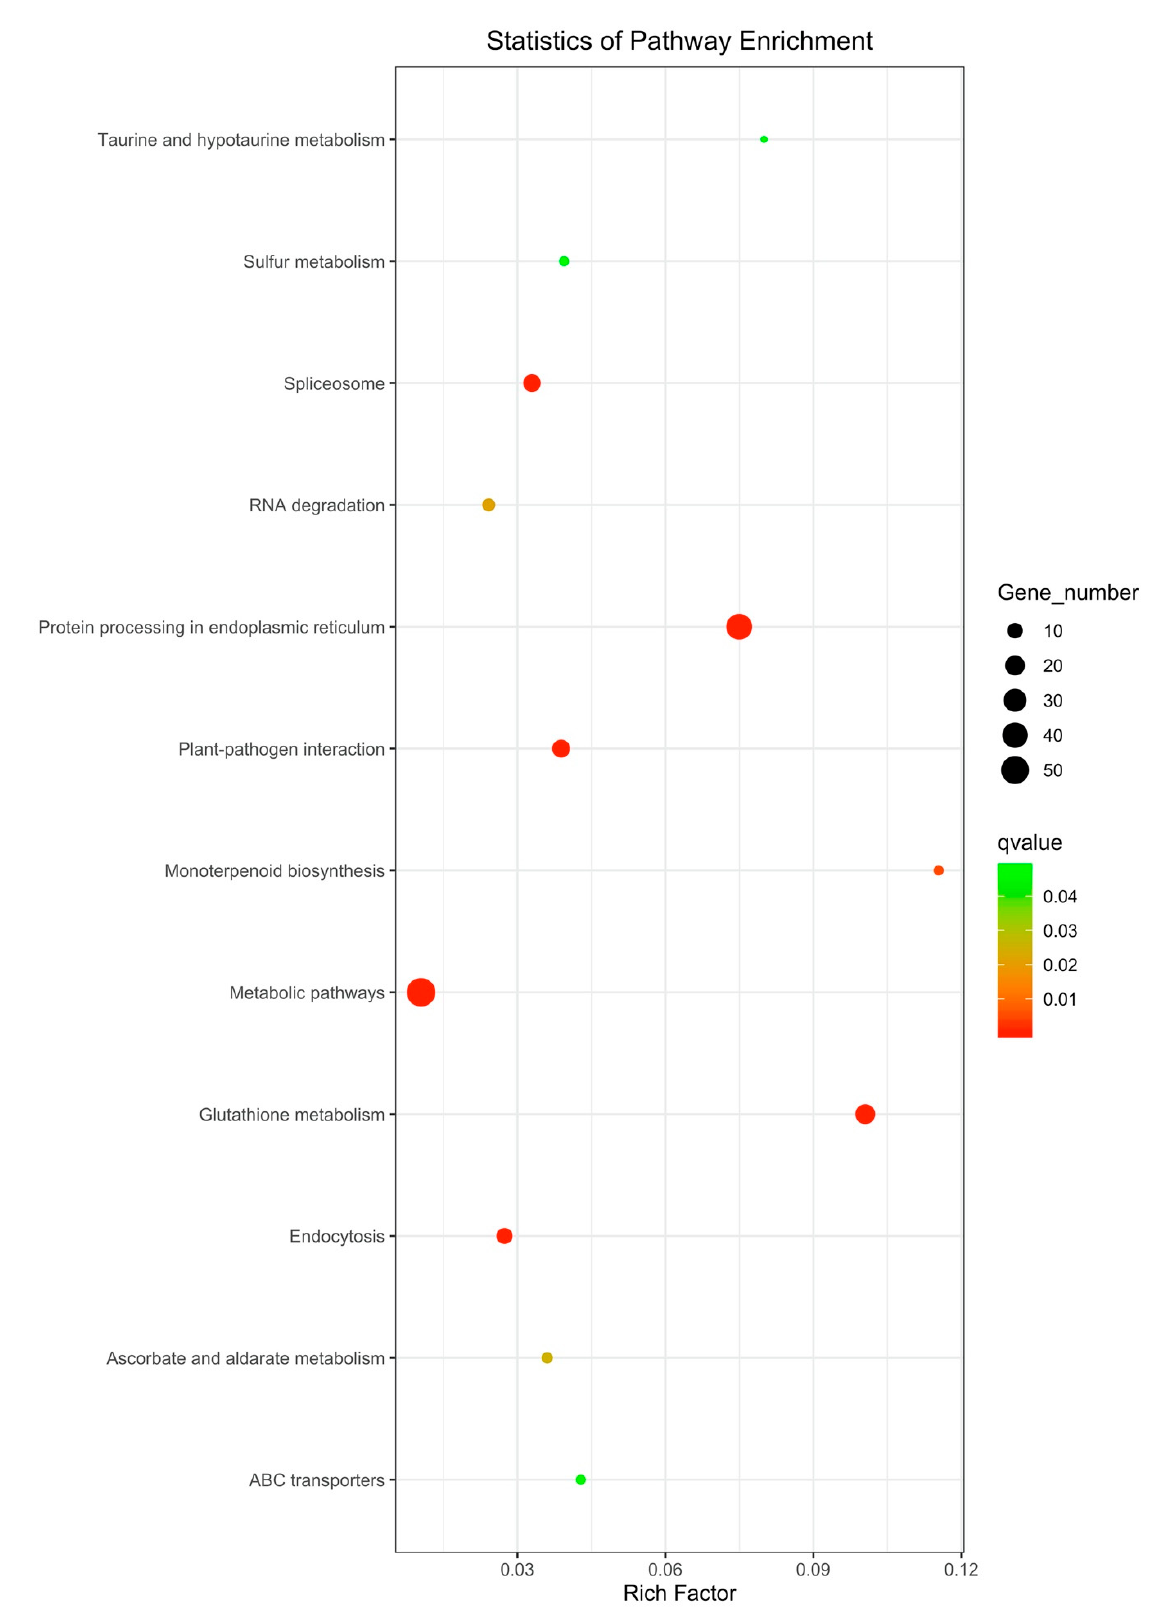
Figure 7. KEGG pathways enriched for down-regulated DEGs in K 326 Wz/Wz inoculated with the Wz -H isolate of P. nicotianae compared to inoculated Hicks. The y -axis indicates the name of the KEGG pathway. The dot size means the gene number. The dot color indicates the q -value.